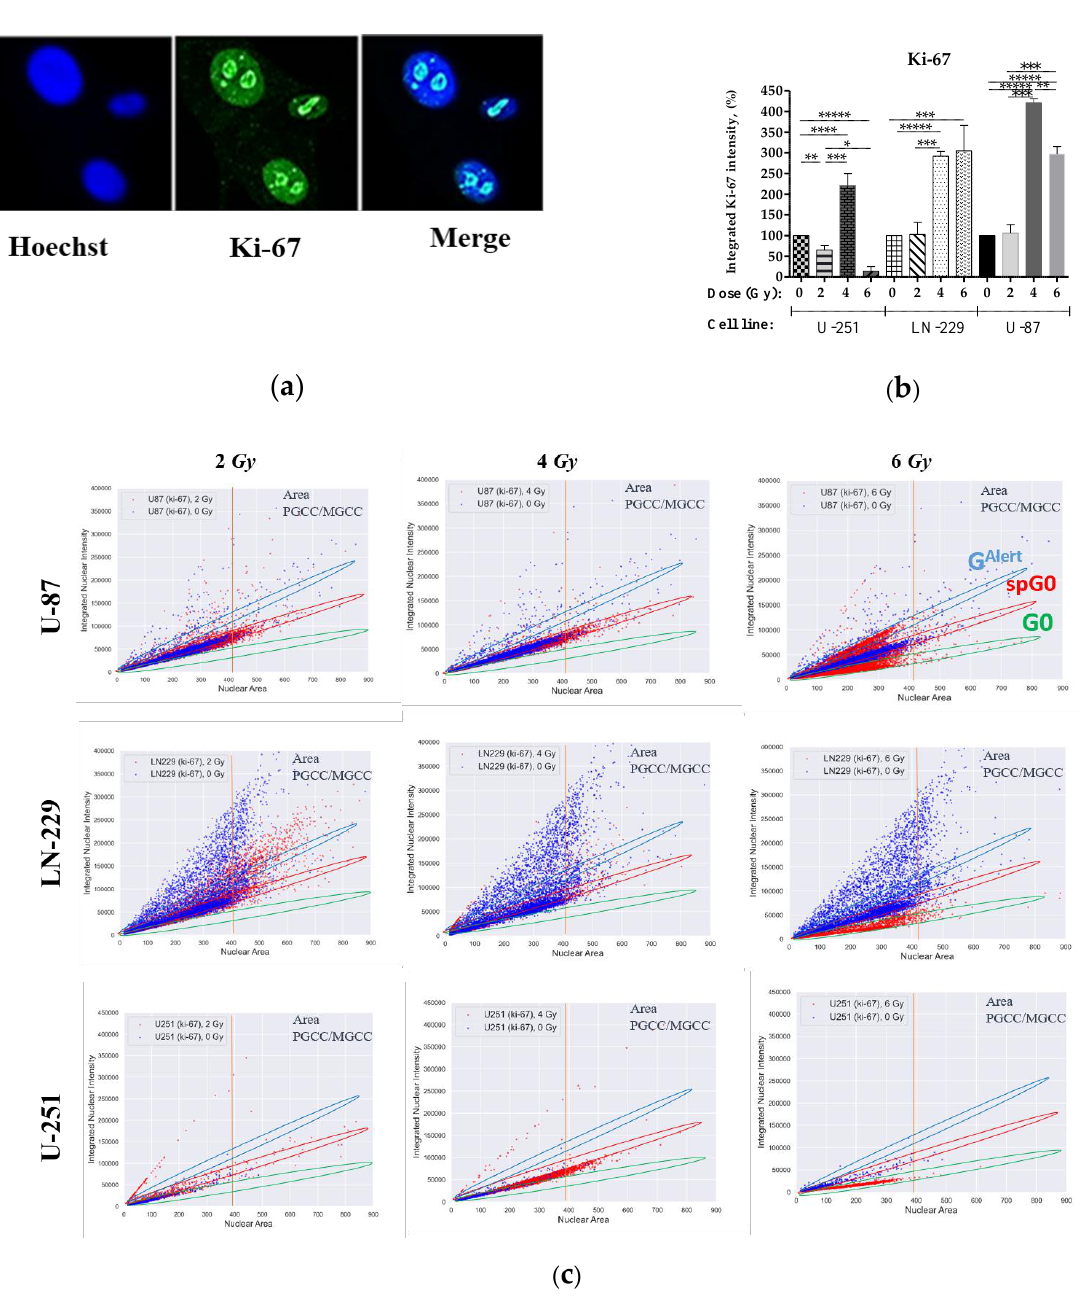
Figure 3. Ki67-coupled fluorescence-intensity analysis. ( a ) Representative immunofluorescence images of cell nuclei (Hoechst 33,342 (blue), Ki-67-stained nuclei (green), and merged images). ( b ) The percentage of Ki-67+ GBM cells in the treated cells was compared with that of the control after normalizing with nuclear counts. ( c ) High-content imaging and analysis of Ki-67-coupled fluorescence of control (blue dots) and irradiated (red dots) GBM cells at 24 h after exposure to different doses of X-rays (cells were seeded in a 96-well plate at a concentration of 2 × 10 2 cells/0.32 cm 2 ). PGCC area denotes the nuclear area threshold to delineate PGCCs/MGCCs of each cell line. The color segmentation of different populations (G Alert , spG0 and G0). Data are means ± SEM of more than three independent experiments. * p ≤ 0.05, ** p ≤ 0.01, *** p ≤ 0.001, **** p ≤ 0.0001, ***** p ≤